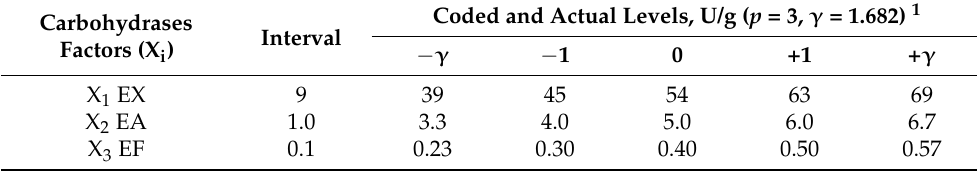
Table 3. Independent variables (X i ) and their ranges used for the zymogram optimization in the Box–Behnken